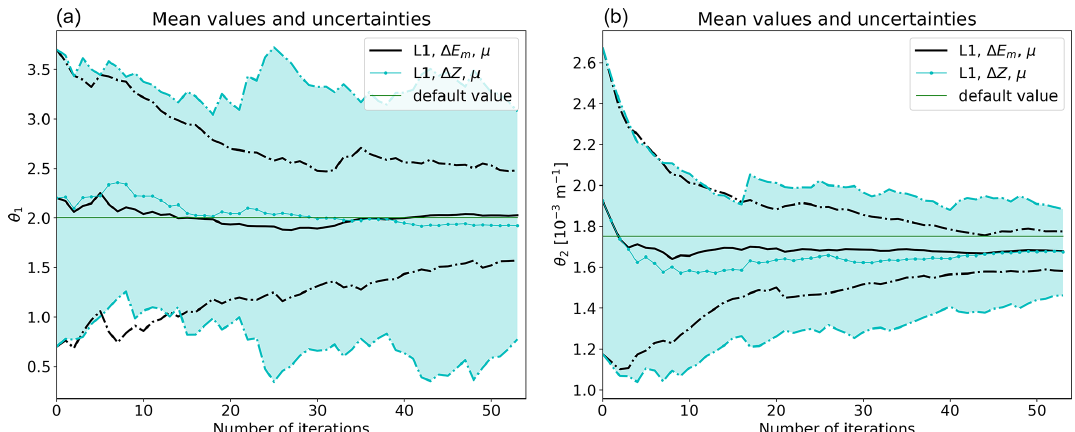
Figure 2. Convergence tests with different cost functions: (a) θ 1 and (b) θ 2 . The x axes show running number of iterations. Solid black lines show the evolution of distribution mean values ( µ ) and dash-dotted black lines the mean values ± 2 standard deviations when (cid:49)E m is used as the cost function. Dotted cyan lines and shading in the background show the same for (cid:49)Z . Default value shows the fixed parameter value used in the default model. Both convergence tests are L1 tests with 50 ensemble members and 48h forecasts. EPPES is used as an optimiser.